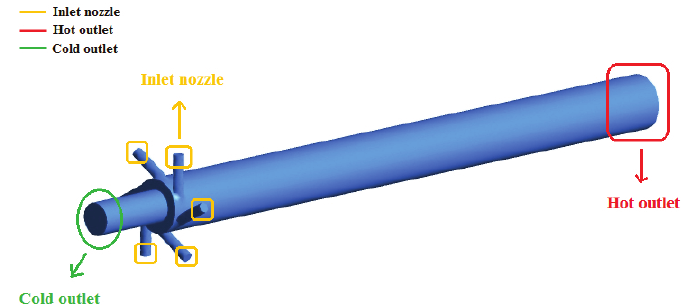
Figure 2. A schematic diagram of the two-dimensional axisymmetric model